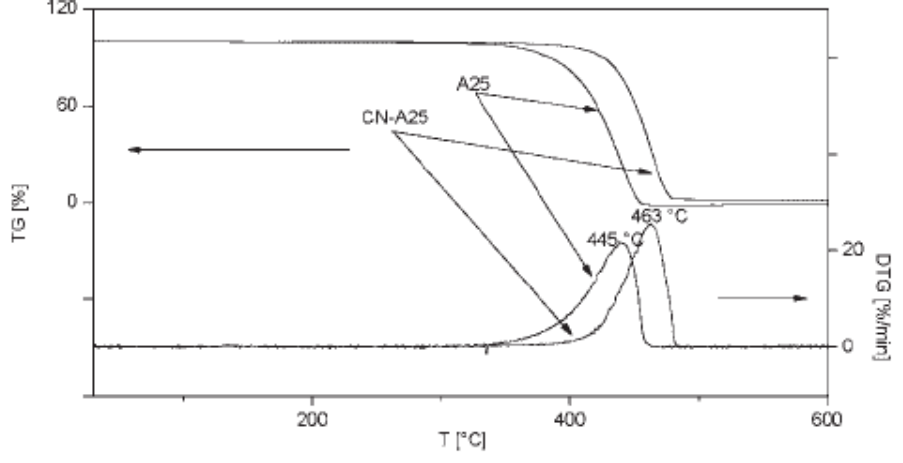
Figure 52. TG-DTG analysis in nitrogen of sPP/CNTs nanocomposites A25; CNA25. Reproduced with permission from ref.